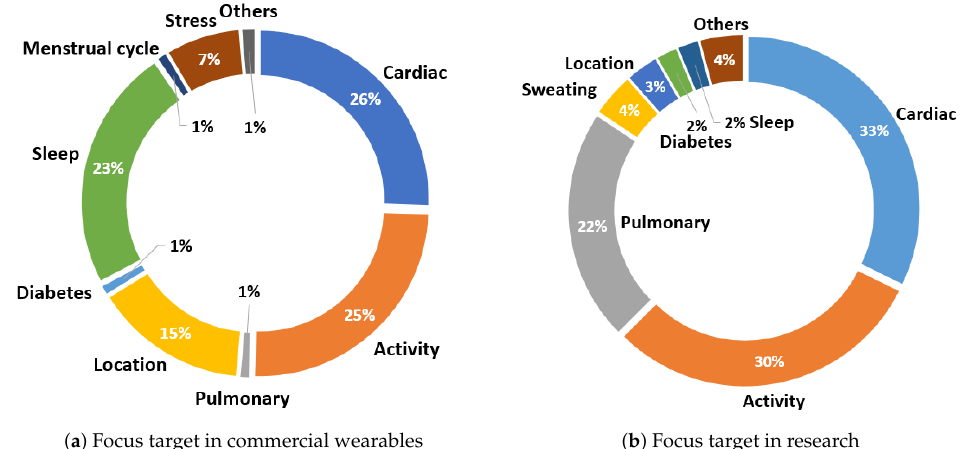
Figure 18. Focus target of the works found in the marketed devices ( a ) and those developed in the literature ( b